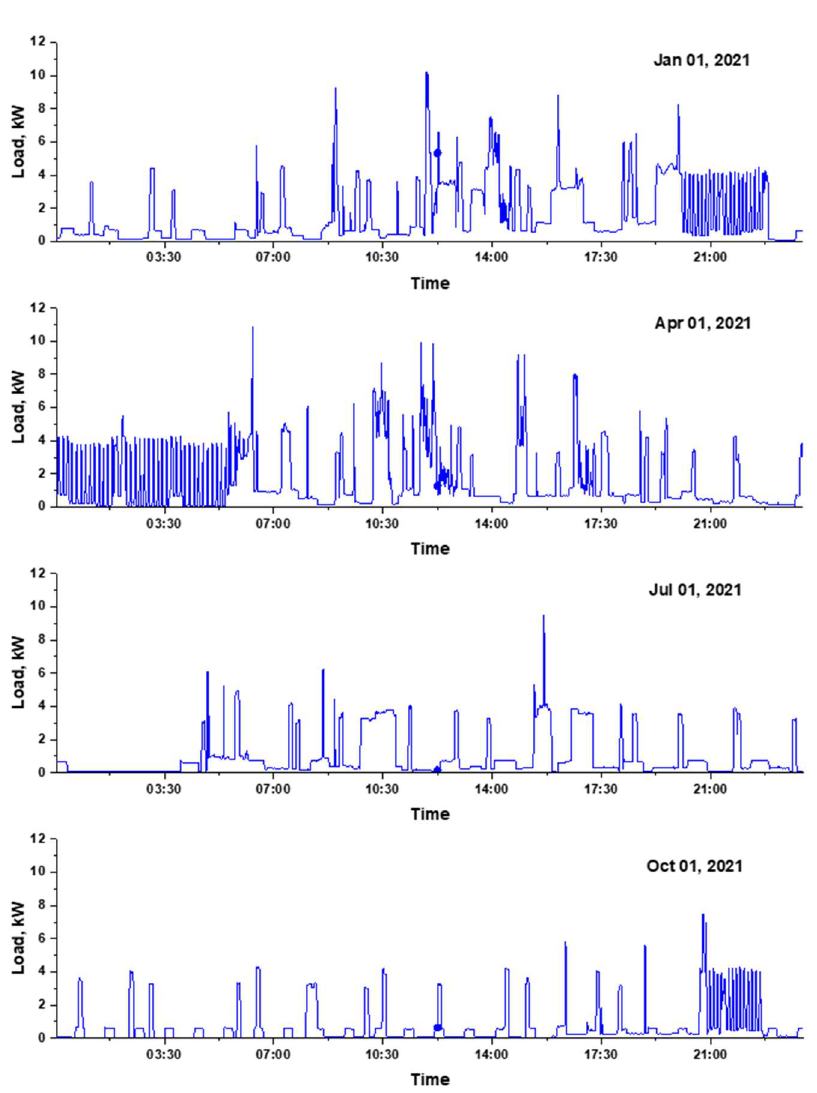
Figure 2. The experimental load profiles for four selected days.